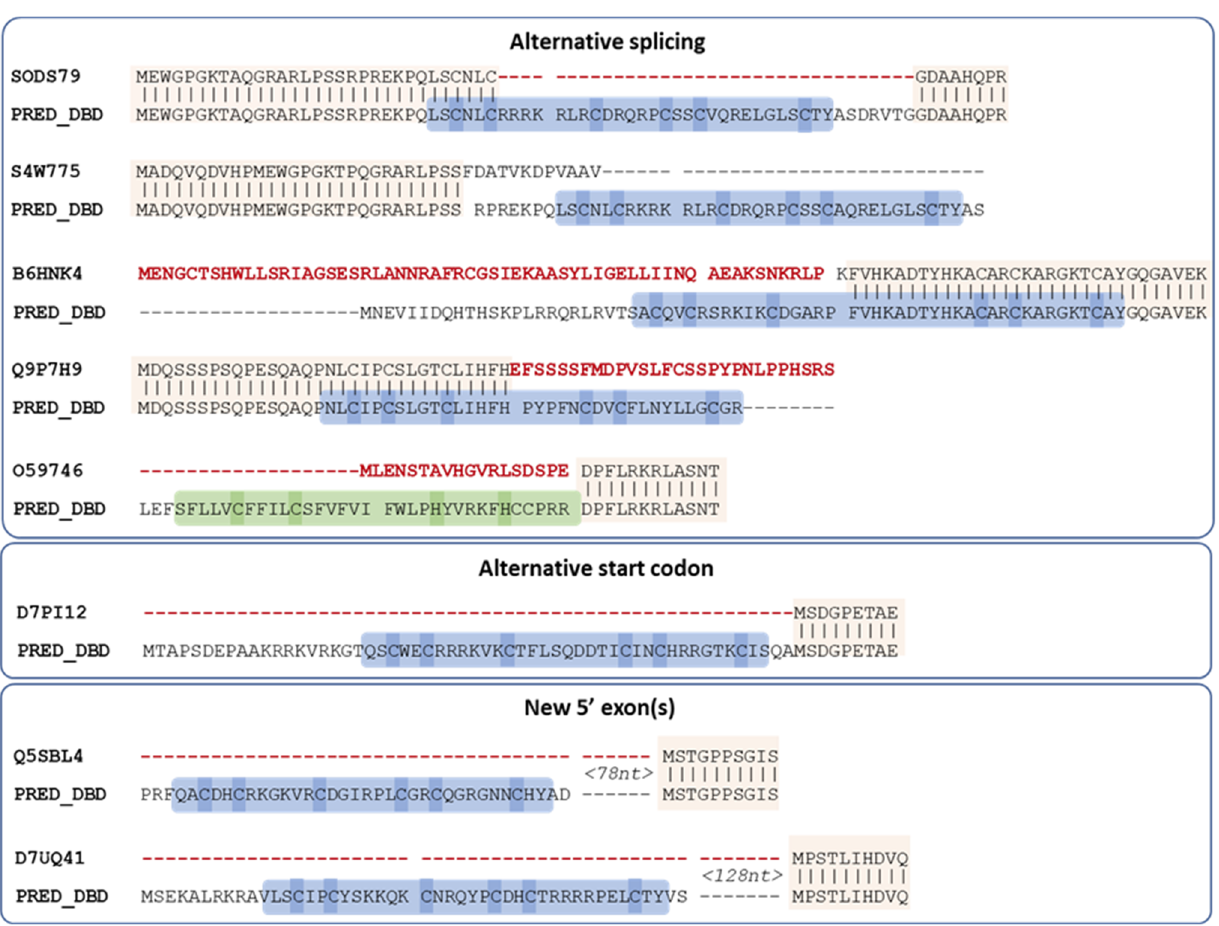
Figure 4. Proposed new sequences for missing DBD of Swiss-Prot MHD proteins. Conserved regions between the existing Swiss-Prot sequence and the proposed sequence are indicated by vertical lines. Regions in the existing Swiss-Prot sequence shown in red are replaced in the predicted sequence, while the predicted DBD is outlined in blue (Zn2C6) or green (C2H2), with cysteines/histidines corresponding to potential zinc binding amino acids highlighted in blue or green. Spaces in the sequences indicate annotated or predicted splice